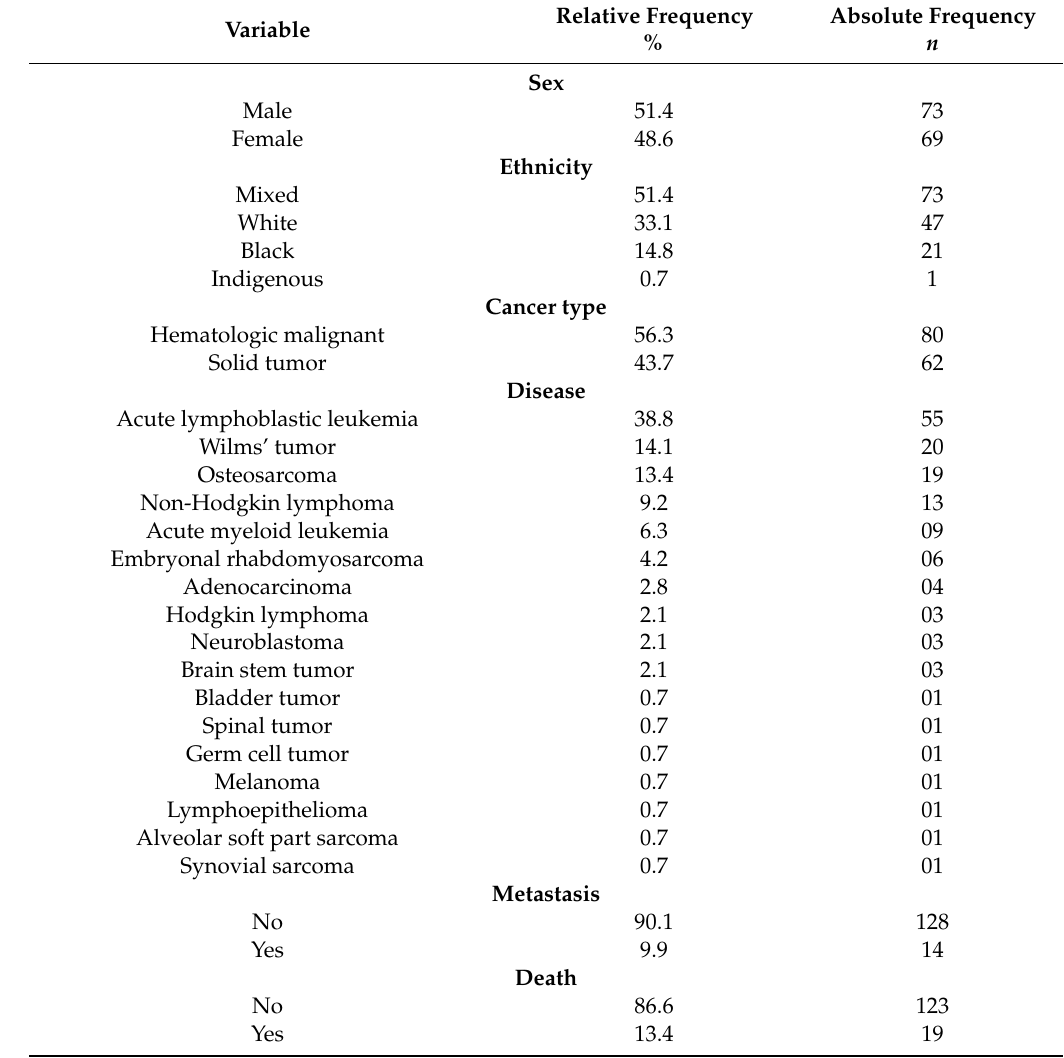
Table 1. Distribution of absolute and relative frequencies of sociodemographic variables corresponding to pediatric cancer patients receiving cancer treatment at a referral hospital, Jo ã o Pessoa,